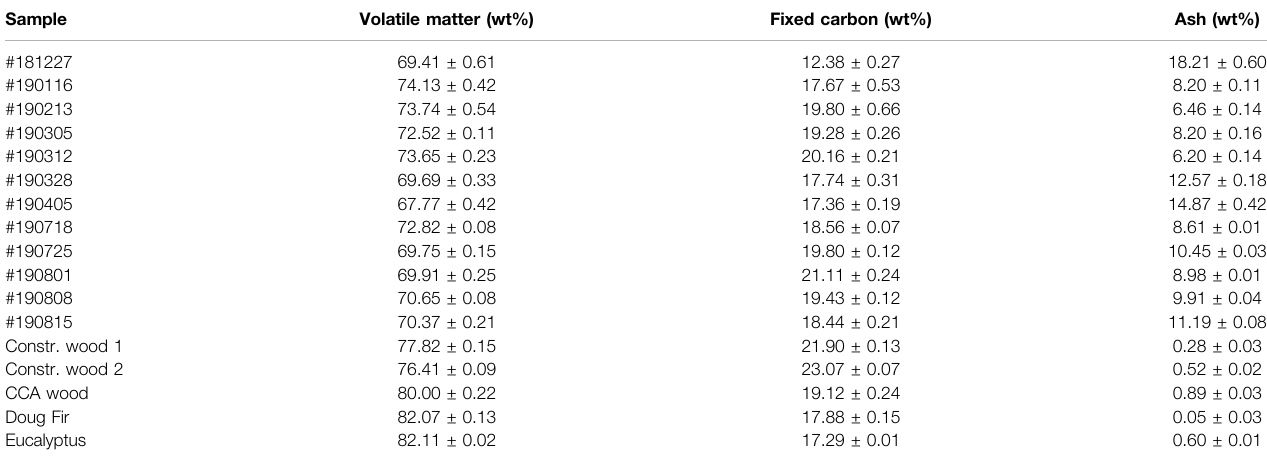
TABLE 3 | Proximate analysis of CCDWDF materials and reference woods (on dry basis). Sample Volatile matter (wt%) Fixed carbon